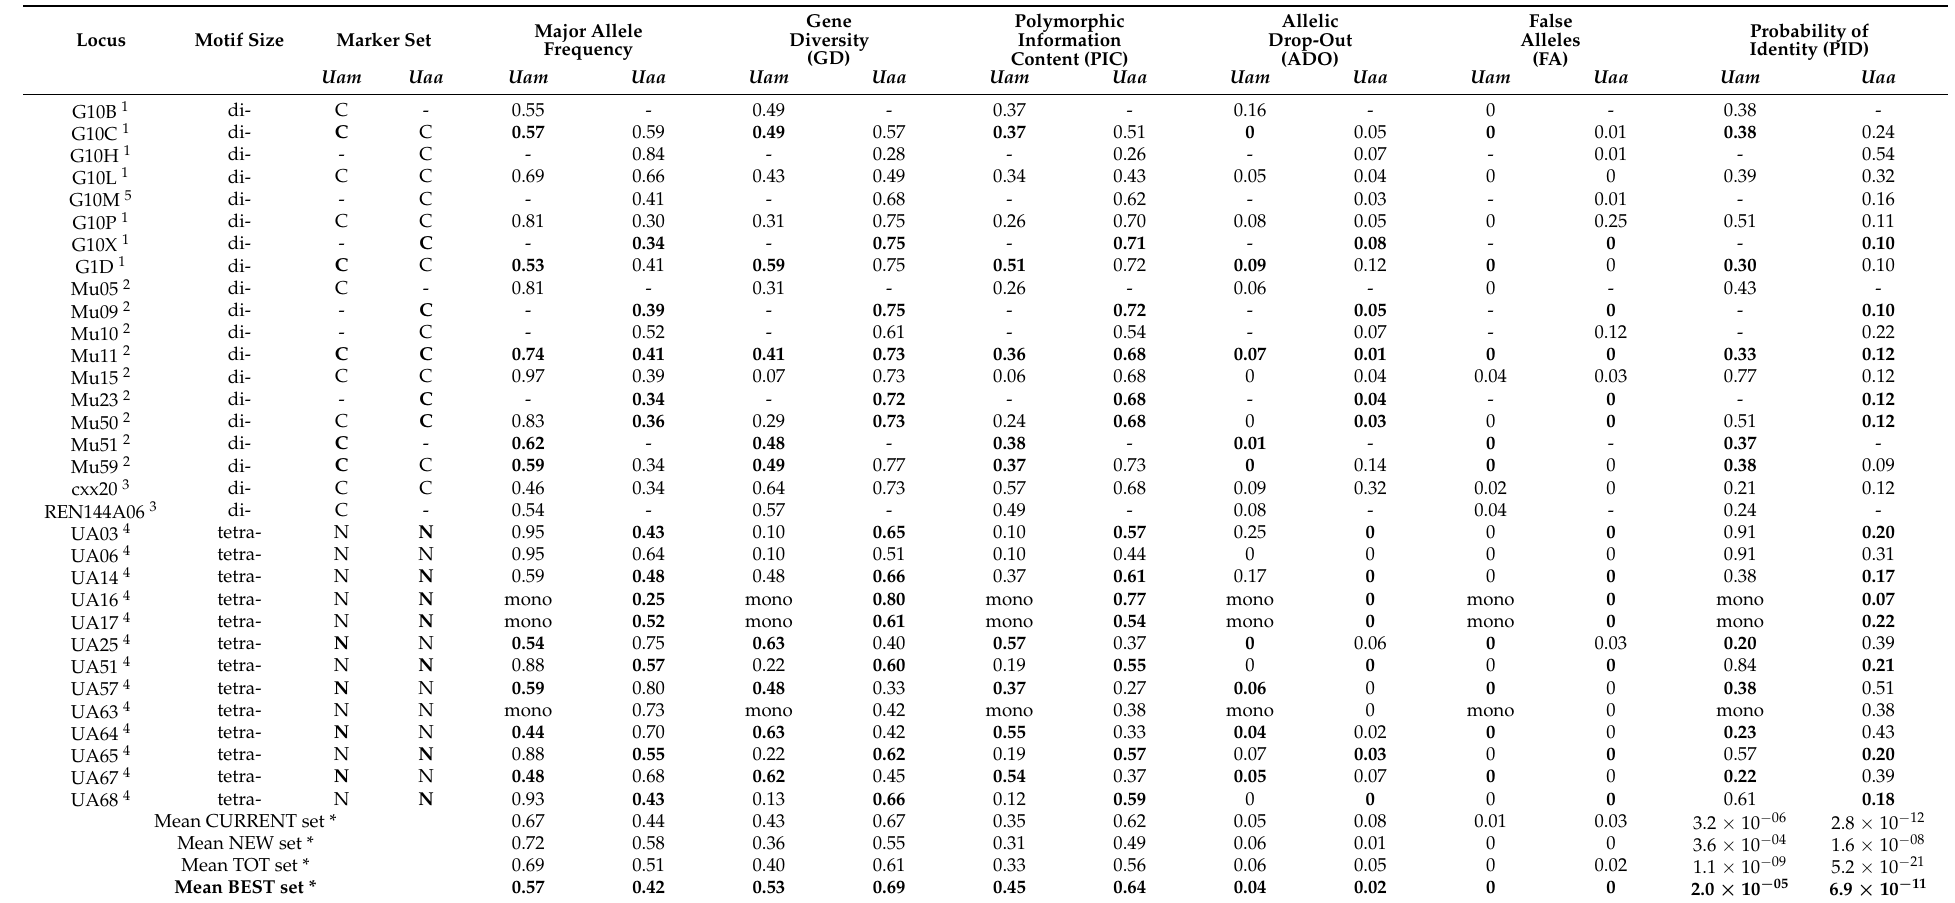
Table 3. Details of microsatellite markers compared in this study. The BEST loci selected for long-term monitoring projects for U. a. marsicanus ( Uam ) and U. a. arctos ( Uaa ) are shown in